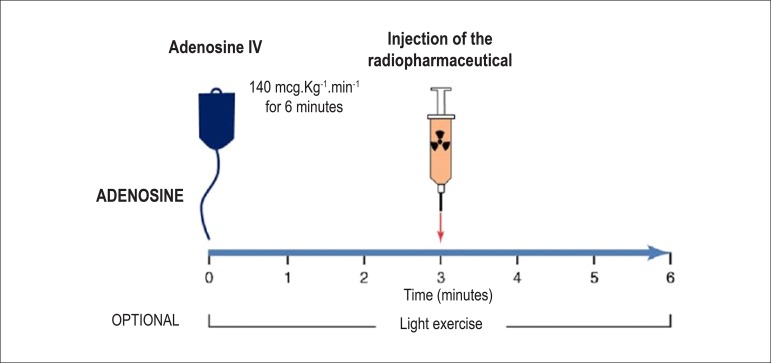
Myocardial perfusion scintigraphy associated with injection of adenosine. The need for continuous intravenous administration is due to the drug’s ultrashort plasma half-life (2 to 10 seconds), with the aim of maintaining coronary hyperemia, which reaches its peak close to the third minute. At this moment, the radiopharmaceutical (MIBI-99mTc) is injected. After completing the solution at 6 minutes, frequent monitoring of blood pressure, heart rate, and electrocardiographic registers is maintained for a variable time of 4 to 6 minutes